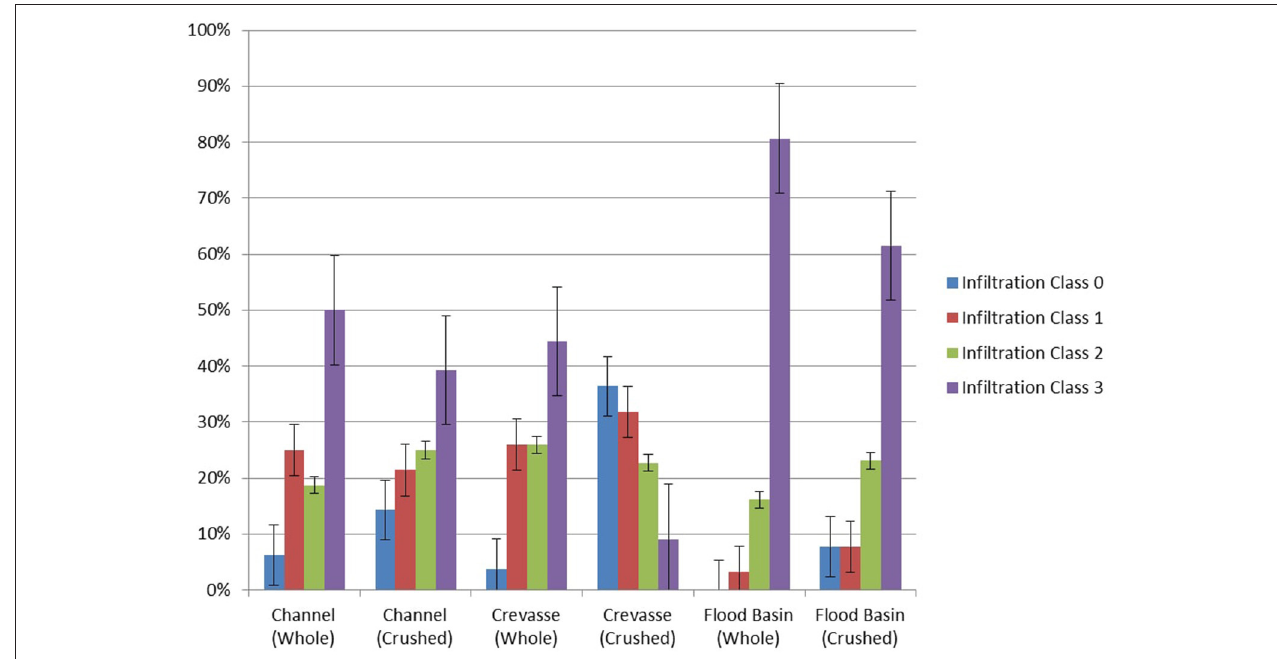
FIGURE 5 | Degree of biofilm infiltration of Haversian and Volkmann’s canals of bone samples in various burial media and biostratinomic conditions. Error bars represent standard